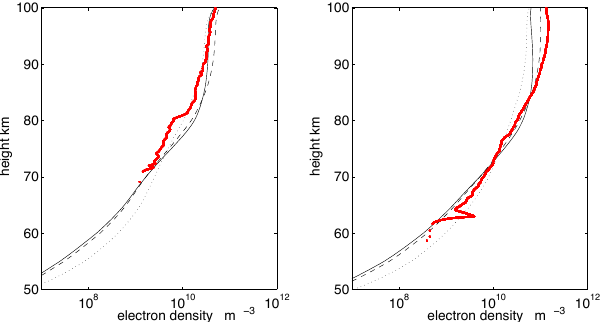
Figure 8. Comparison of modelled and measured electron densi- ties on 21 March 2013; median values at 11:45–12:15UT (left-hand panel) and 09:15–10:15UT (right-hand panel). Black lines show model results based on measured CNA and the HSS-mean model (solid lines), the HSS-UQ model (dashed lines) and the HSS-LQ model (dotted lines). HSS models are as defined in Eqs. (1) and (2) and Table 3. Red lines show measurements from the EISCAT VHF